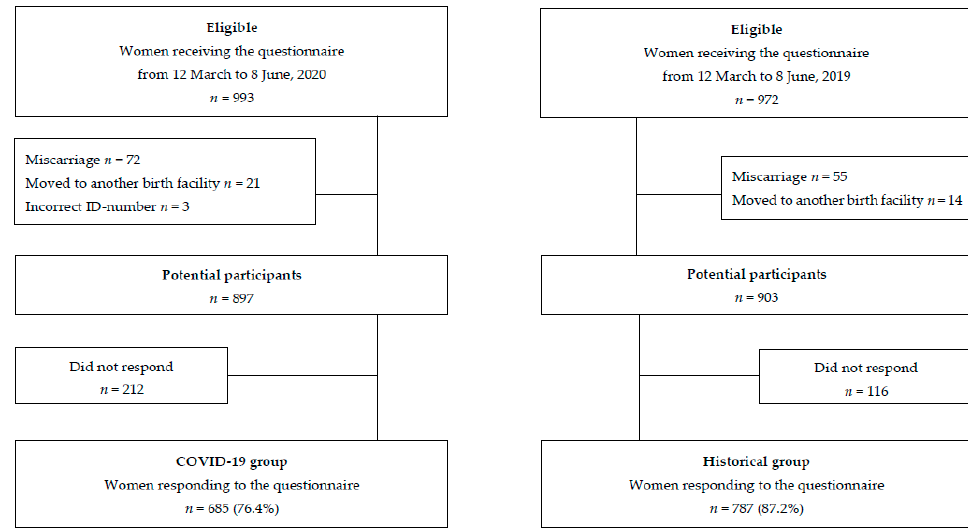
Figure 1. Flowchart of the study population.